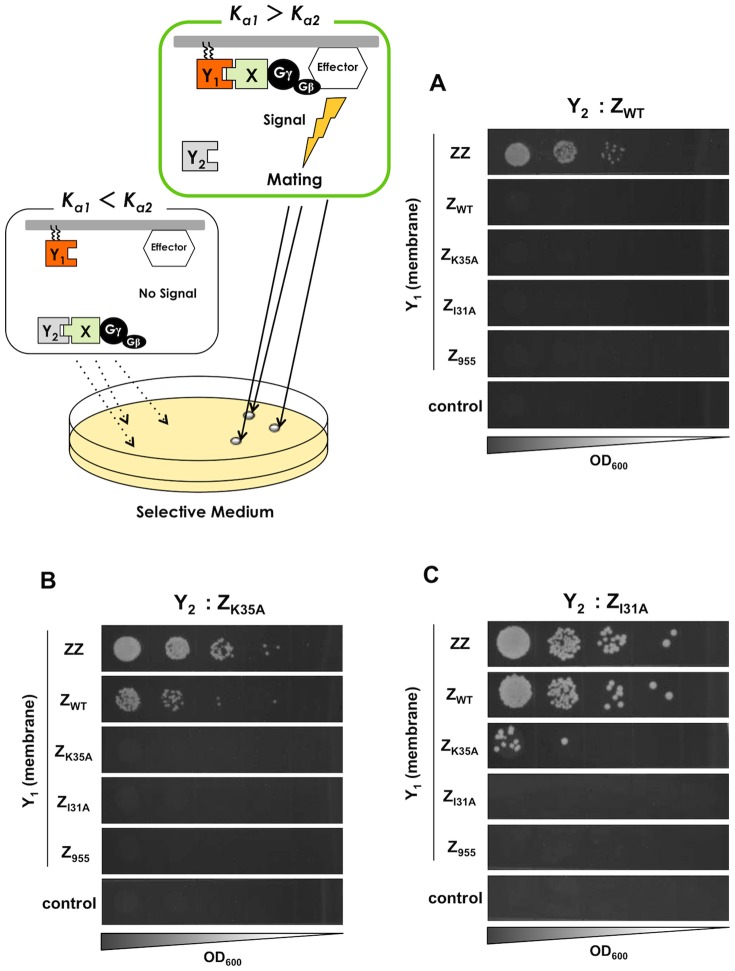
Mating growth selection to test the screening of affinity-enhanced proteins.The signal-promoted cells were isolated as methionine- and lysine-prototrophic diploids. Growth of the engineered strains expressing cytosolic ZWT (A), ZK35A (B) and ZI31A (C) as the parental ‘Y2’ proteins. Five Z variants (ZZ, ZWT, ZK35A, ZI31A and Z955) were expressed as the membrane-anchored ‘Y1’ candidate proteins in each strain. Control indicates the yeast strains without the expression of ‘Y1’ (transformed with pGK413 mock vector). BY4742 was used as the mating partner.